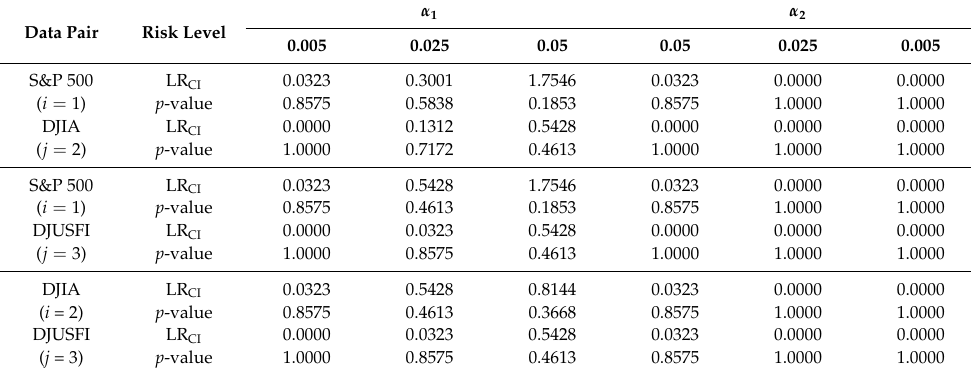
Table 8. Forecast performance measures of the test statistic and p -value of CI test for one-day- ahead VaR return forecasts at the lower and upper risk levels 0.005, 0.025 and 0.05 using the best two-stage MCARR-return model with volatility forecasts from MCARR(1,1,0) 12 , MCARR(1,1,1) 13 and MCARR(1,1,0) 23 models for the S&P 500, DJIA and DJUSFI indices. The subscripts ij in MCARR(1,1,0) ij and MCARR(1,1,1) ij for some i < j and i , j = 1,2,3 refer to i and j data pair.